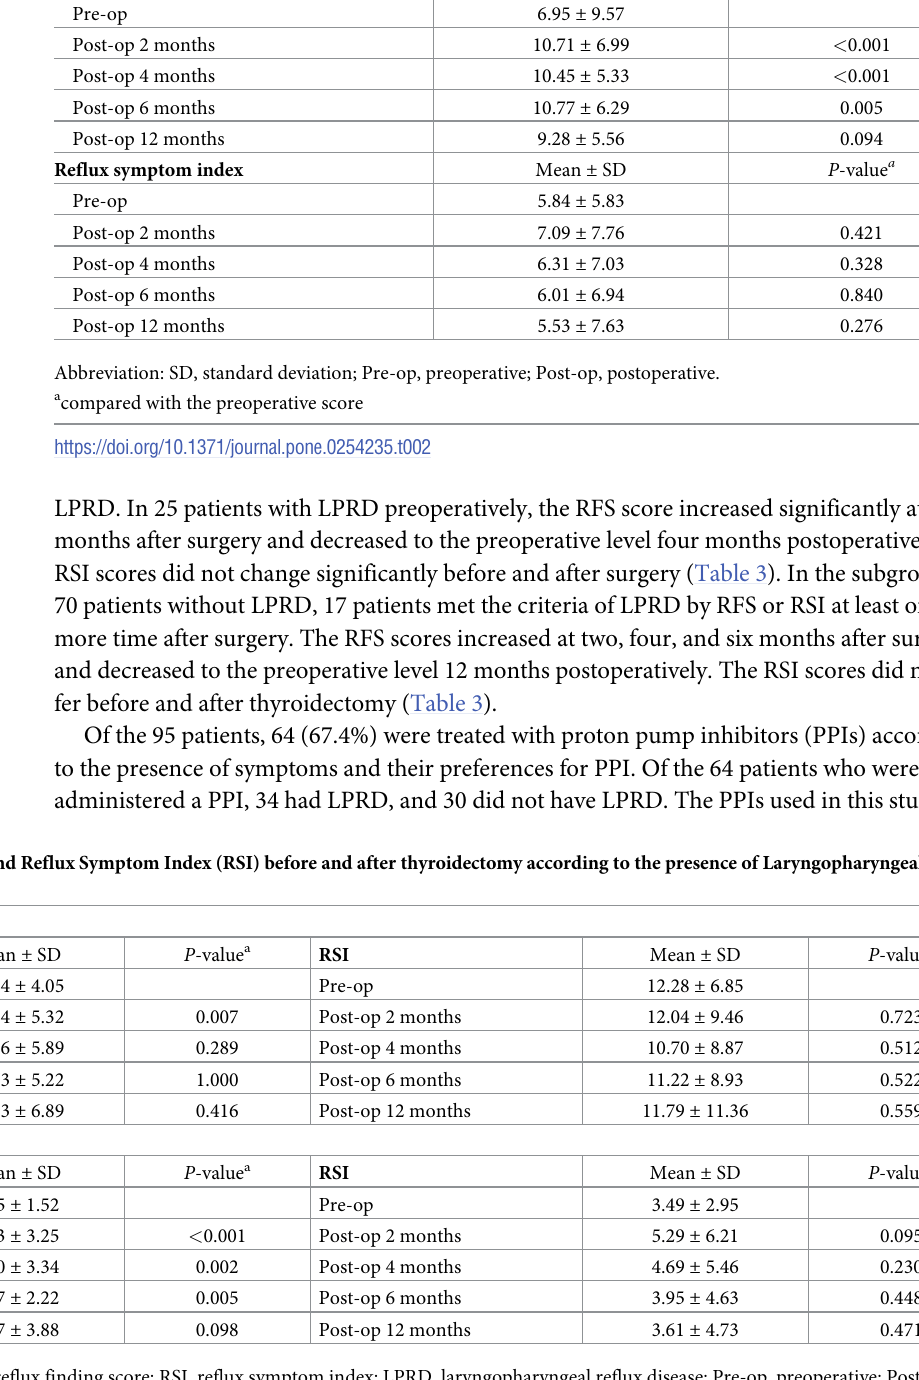
Table 2. The Reflux Finding Score (RFS) and Reflux Symptom Index (RSI) before and after thyroidectomy (n = 95).